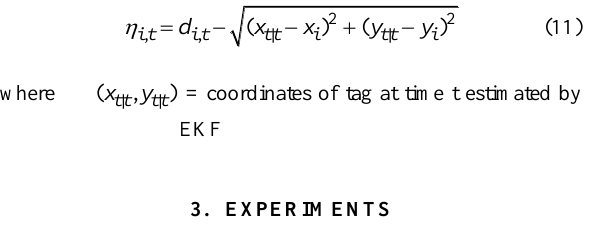
Fig. 5. The ranging accuracy of both tags is less than 15 cm.